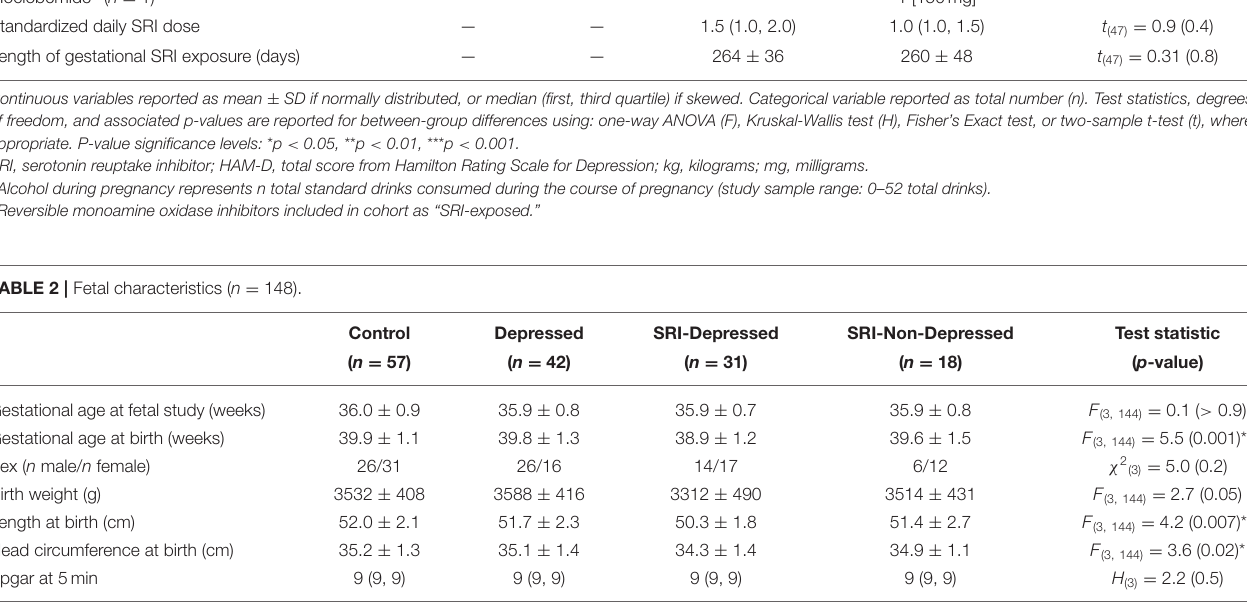
Figure 2 shows the inter-individual variability in concentration-time curves across the study protocol, grouped by antidepressant type. Baseline levels between T 0 and T 1 were the lowest plasma concentrations, reflecting a pharmacologic trough at apparent steady-state prior to oral SRI dose, which occurred (IQR): 24–27) since the reported previous dose. Concentration- time curves illustrate an expected increase in plasma drug concertation as part of the absorption phase following oral dose, with individuals on citalopram, paroxetine and sertraline, as well as some individuals on venlafaxine, reaching